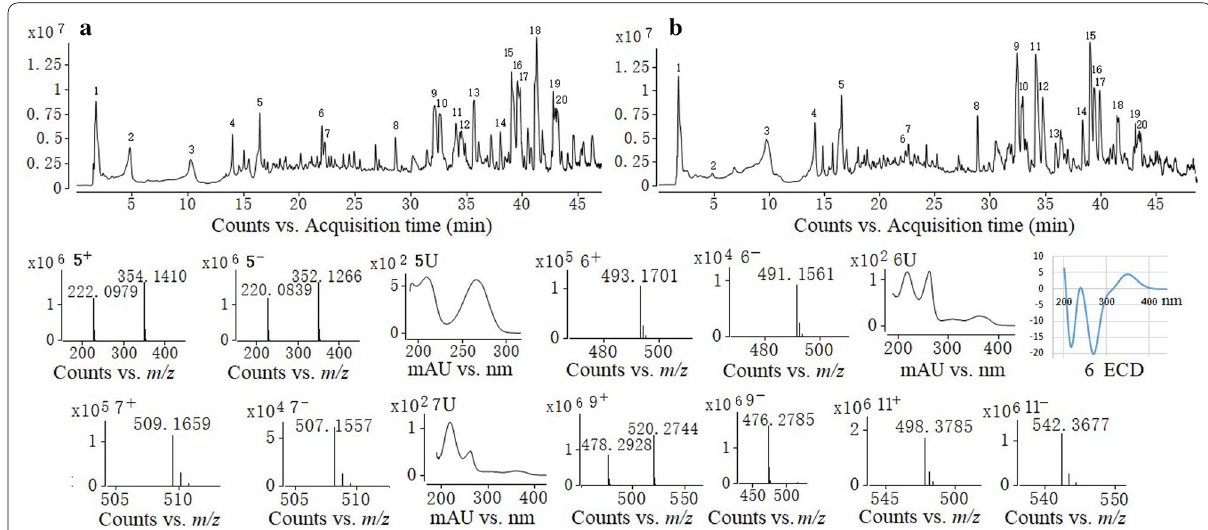
Fig. 1 HPLC-HRMS analysis of the extract form spores and mycelia of Cordyceps fumosorosea. A is the base peak chromatogram of the crude extract in positive model; B is the base peak chromatogram of the crude extract in negative model; number 5, 6, 7, 9 and 11 are the five possible unknown metabolites, and ‘ ’, ‘ ’, ‘U’ and ‘ECD’ mean cation, anion, ultraviolet spectrum and circular dichroism of the metabolites + −